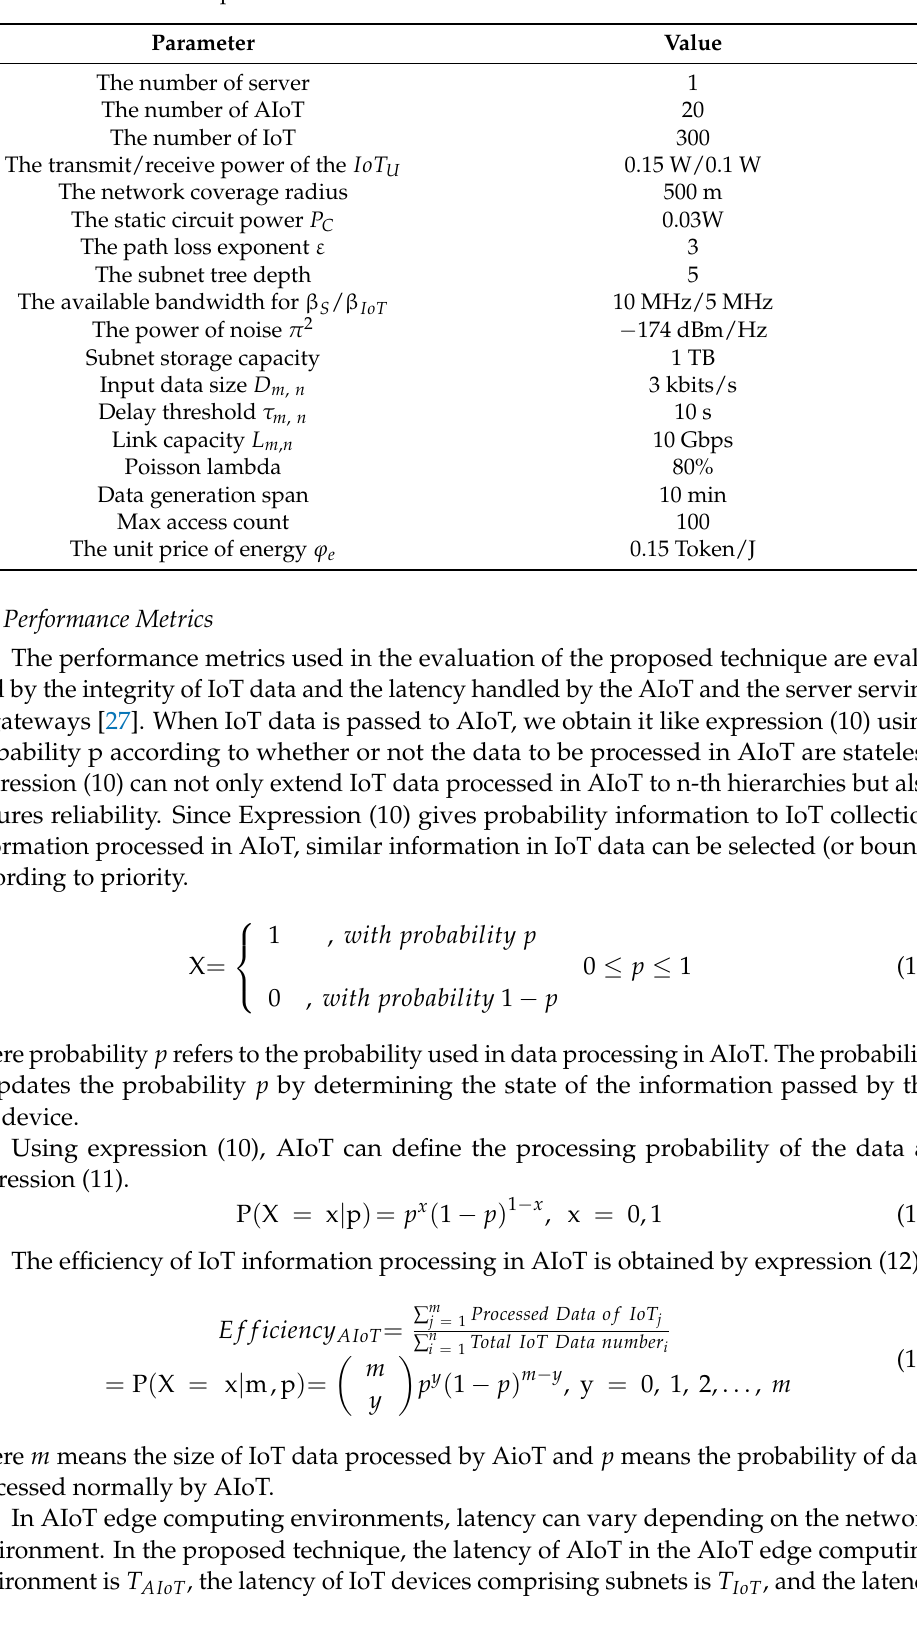
Table 2. Environment